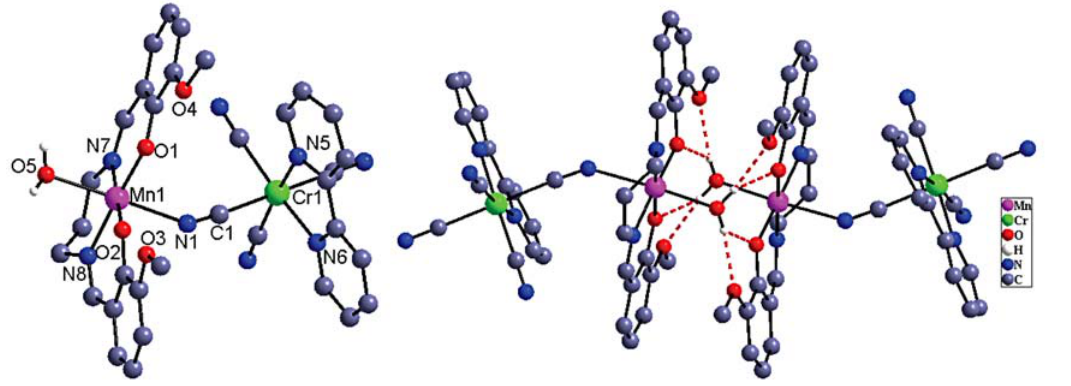
Figure 1. The neutral binuclear structure (left) and the dimer constructed by intermolecular hydrogen bond interactions (right) for complex 1 . Sol- vent molecules and the hydrogen atoms not involved in hydrogen-bonding have been omitted for clarity.